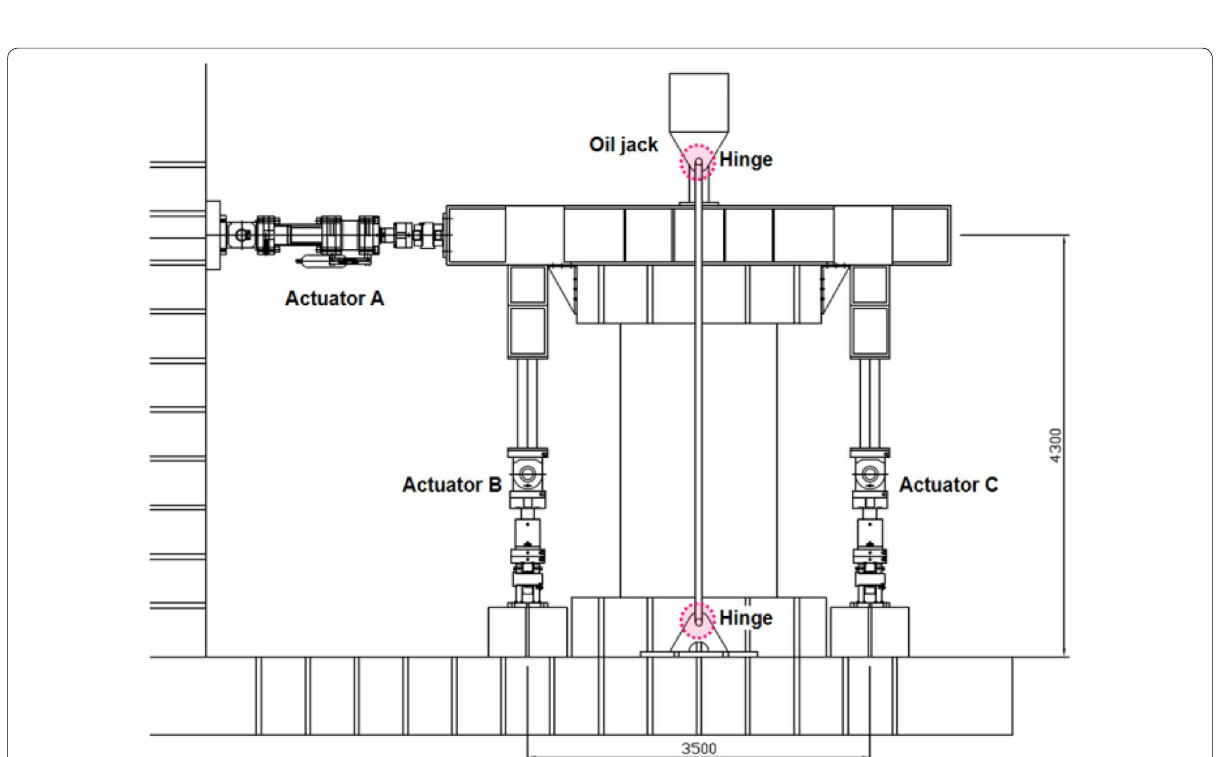
Fig. 5 Installation of test